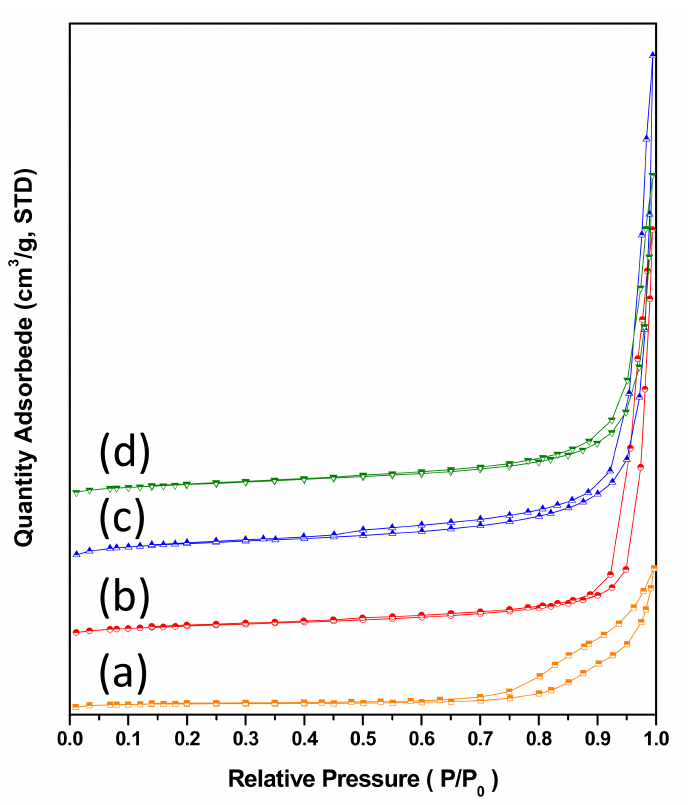
Figure 3. Nitrogen adsorption/desorption isotherm of as-prepared calcium-based sorbents: